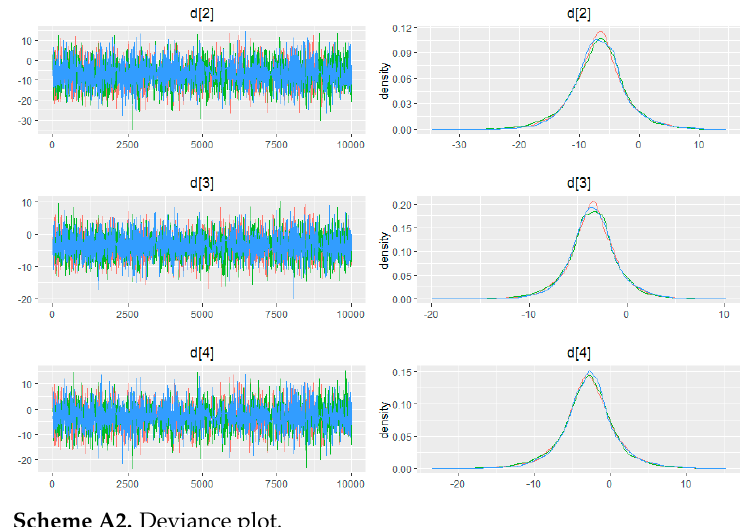
Scheme A1. Gelman convergence plot.